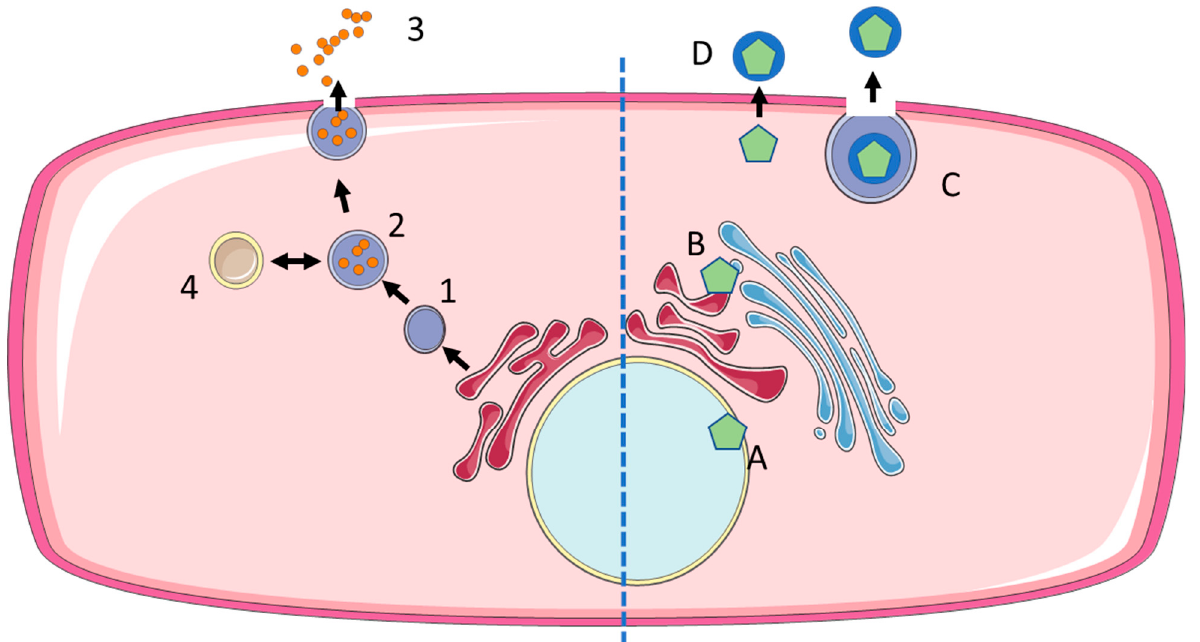
Figure 3. Biogenesis of exosomes and enveloped viruses. EXOs are produced from late endosomes (1) by the formation of interluminal vesicles (2), which are either released at the cell membrane to become exosomes (3) or recycled via fusion with lysosomes (4). Enveloped viruses acquire their envelope at different sites: nuclear envelope (A), endoplasmic reticulum or Golgi apparatus (B), followed by the release of exocytic vesicles containing virus particles (C). Alternatively, enveloped virus particles may acquire their envelope directly at the cell membrane (ectosomal budding) (D).